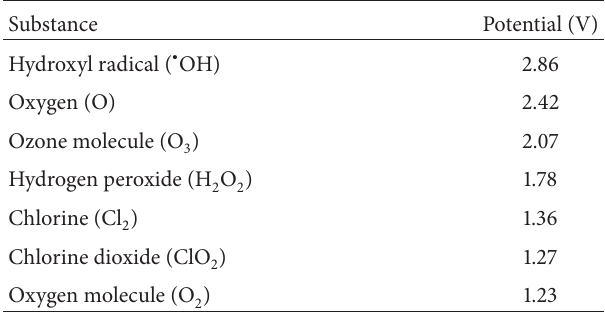
Table 1: The oxidation potential of various reactive